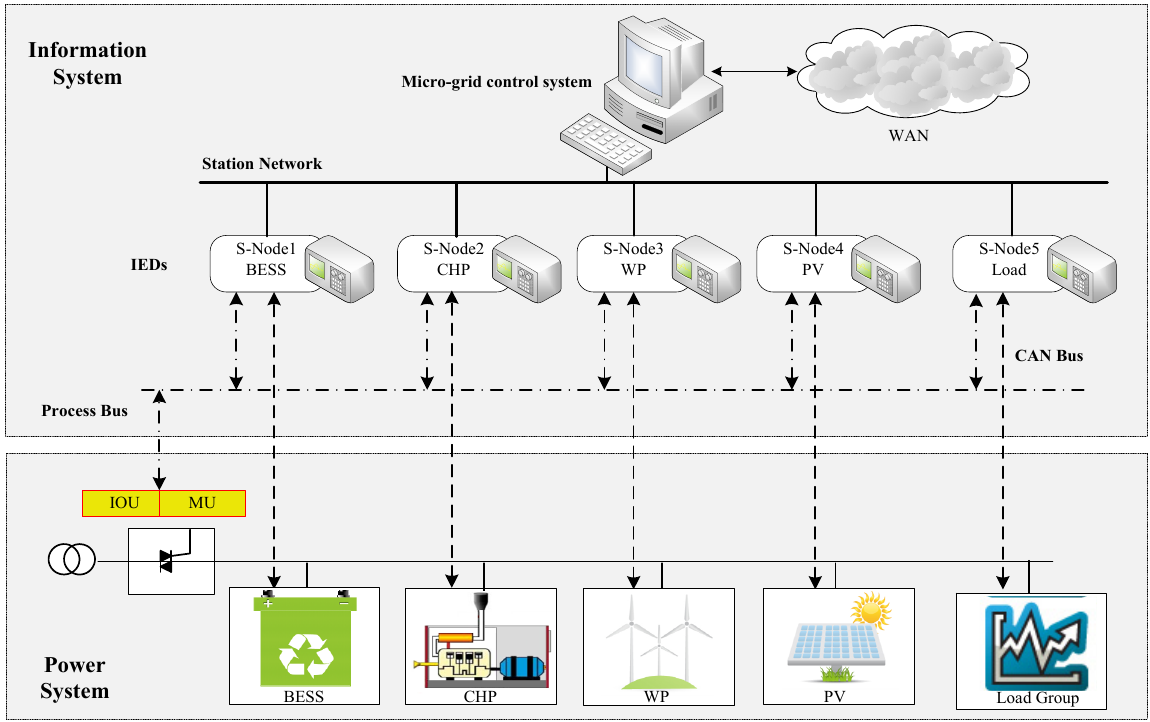
Figure 1. Micro-grid system